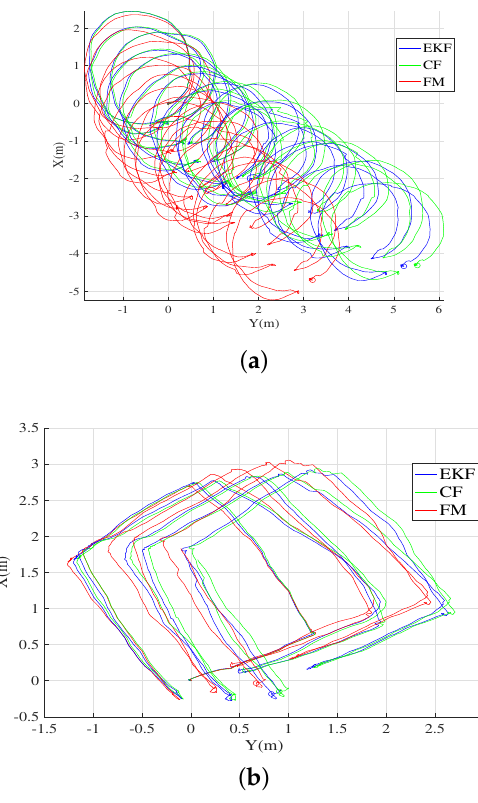
Figure 8. Trajectories calculated in experiment 2. ( a ) circular trajectory; ( b ) rectangular